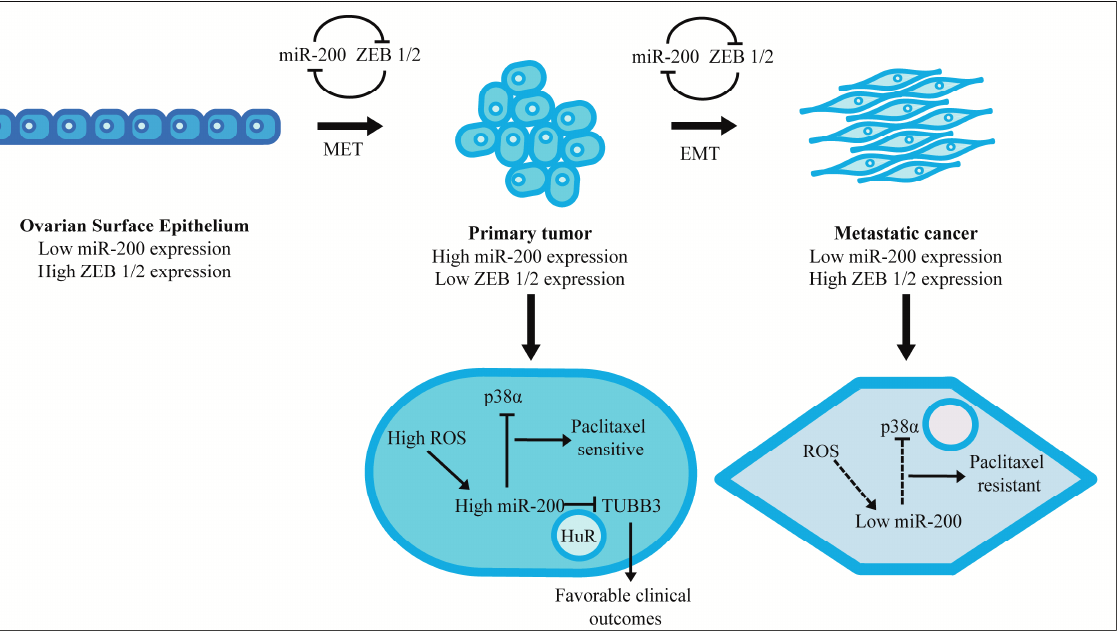
Figure 2. Model for the expression and mechanisms of action of miR-200 adapted from Bendoraite et al. [49], Mateescu et al. [93] and Prislei et al. [91]. miR-200 could